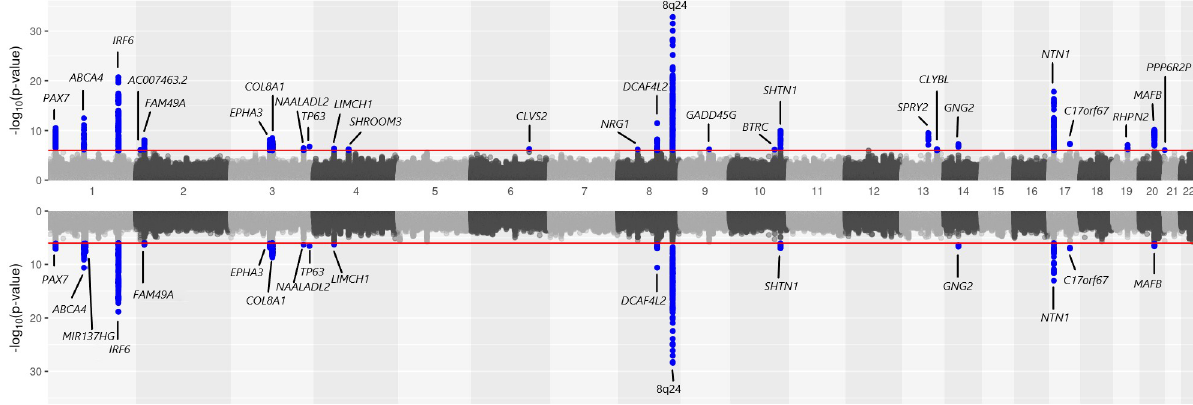
Fig 5. Mirrored Manhattan plot of genome-wide analyses of CL/P, and CL & CLP. Results from genetic associations of CL/P using the gTDT are shown in the upper panel. Results from shared genetic associations between CL & CLP using PLACO are shown in the lower panel. The red horizontal lines in the two panels indicate a suggestive significance threshold of 10 − 6